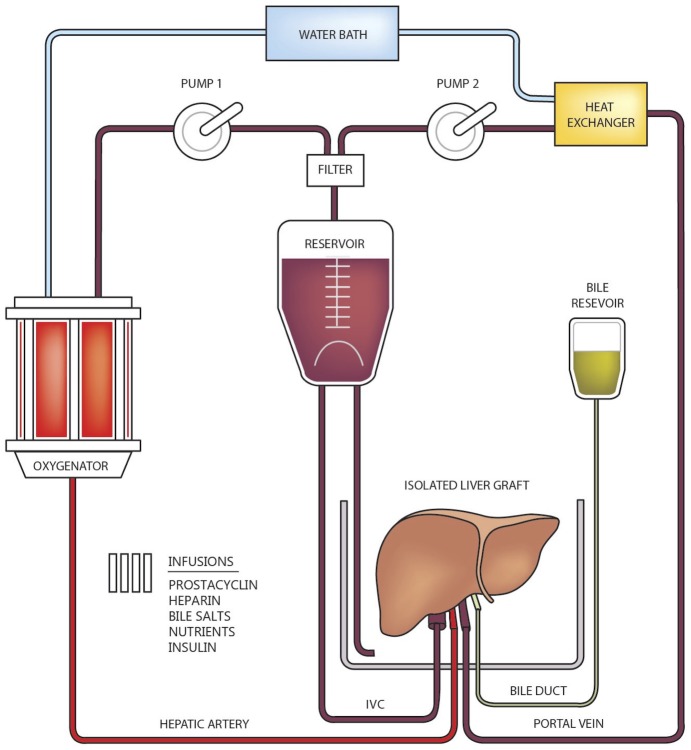
Schematic diagram of the experimental ex situ circuit.In this study prostacyclin, bile salts and nutrients were omitted from the infusions. Reprinted from ‘Mariusz Bral, Boris Gala-Lopez, Aducio Thiesen, Sanaz Hatami, David L. Bigam, Darren M. Freed, AM James Shapiro, Determination of Minimal Hemoglobin Level Necessary for Normothermic Porcine Ex Situ Liver Perfusion, Transplantation. 2018;102(8):1284–1292, with permission from Transplantation.